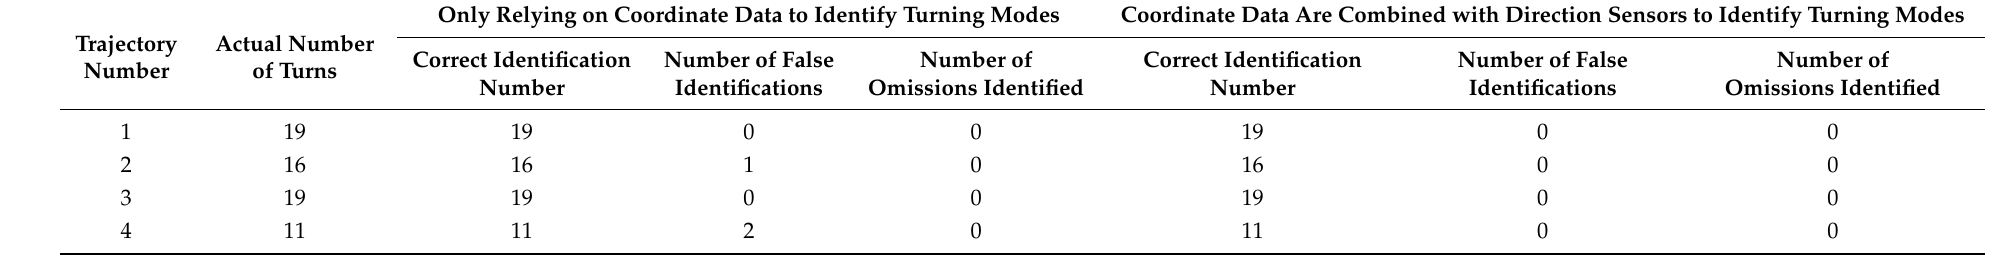
Table 4. Recognition accuracy of turning modes when the compression threshold is set to 7